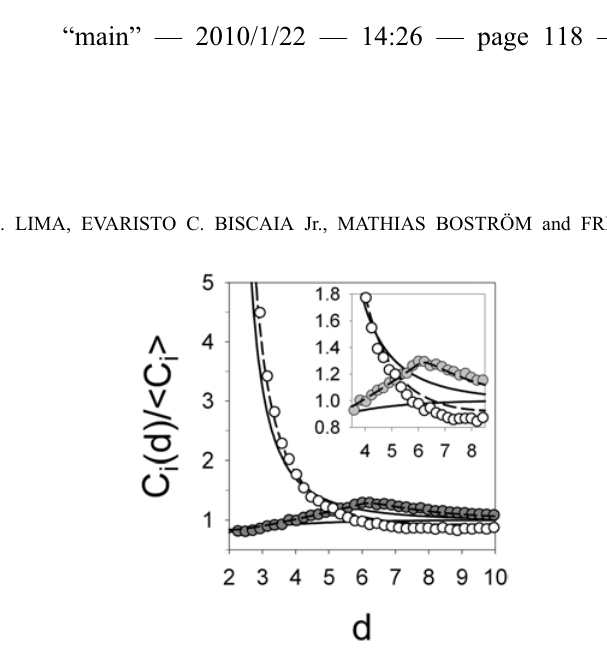
Fig. 4 – Concentration profiles near a macroion ( σ M = 30Å and + 20e 0 ) in solution of ionic strength 1.0 M for Na 2 SO 4 (Boström et al. 2005b). Symbols refer to MC simulation results. Open circles represent counterion concentrations (sulfate) and gray circles the coions (Na + ). Solid lines are numerical solutions of the non-linear Poison-Boltzmann equation, and dashed lines are for the OZ-HNC integral equation. The inner figure shows that the HNC calculations for coion distributions coincide with the simulation